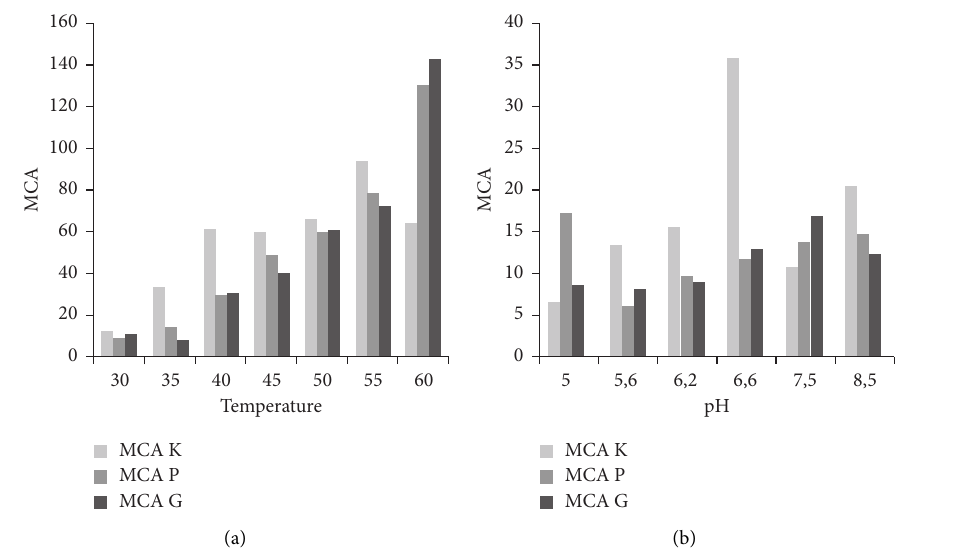
Figure 1: Optimum condition of clotting activity of enzymatic enzyme: (a) optimum temperature; (b) optimum pH. MCA K: milk-clotting activity of kiwi; MCA P: milk-clotting activity of pineapple; MCA G: milk-clotting activity of ginger.